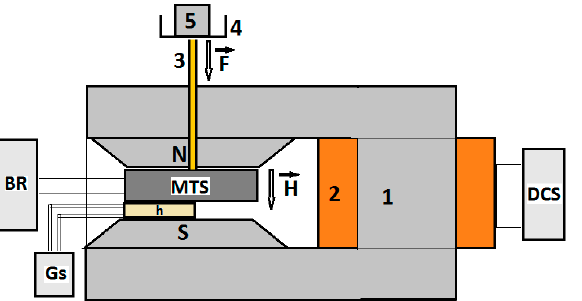
Figure 10. Experimental set-up (overall configuration): (1) Magnetic yoke; (2) coil; (3) non-magnetic axis; (4) plate; (5) marked mass made of lead. BR, RLC bridge; DCS, direct current source; Gs, Gaussmeter; N and S, magnetic poles; MTS, magneto-tactile sensor; h, Hall probe; F(cid:4652)⃗ , compression force vector; H(cid:4652)(cid:4652)⃗ , magnetic field strength vector.